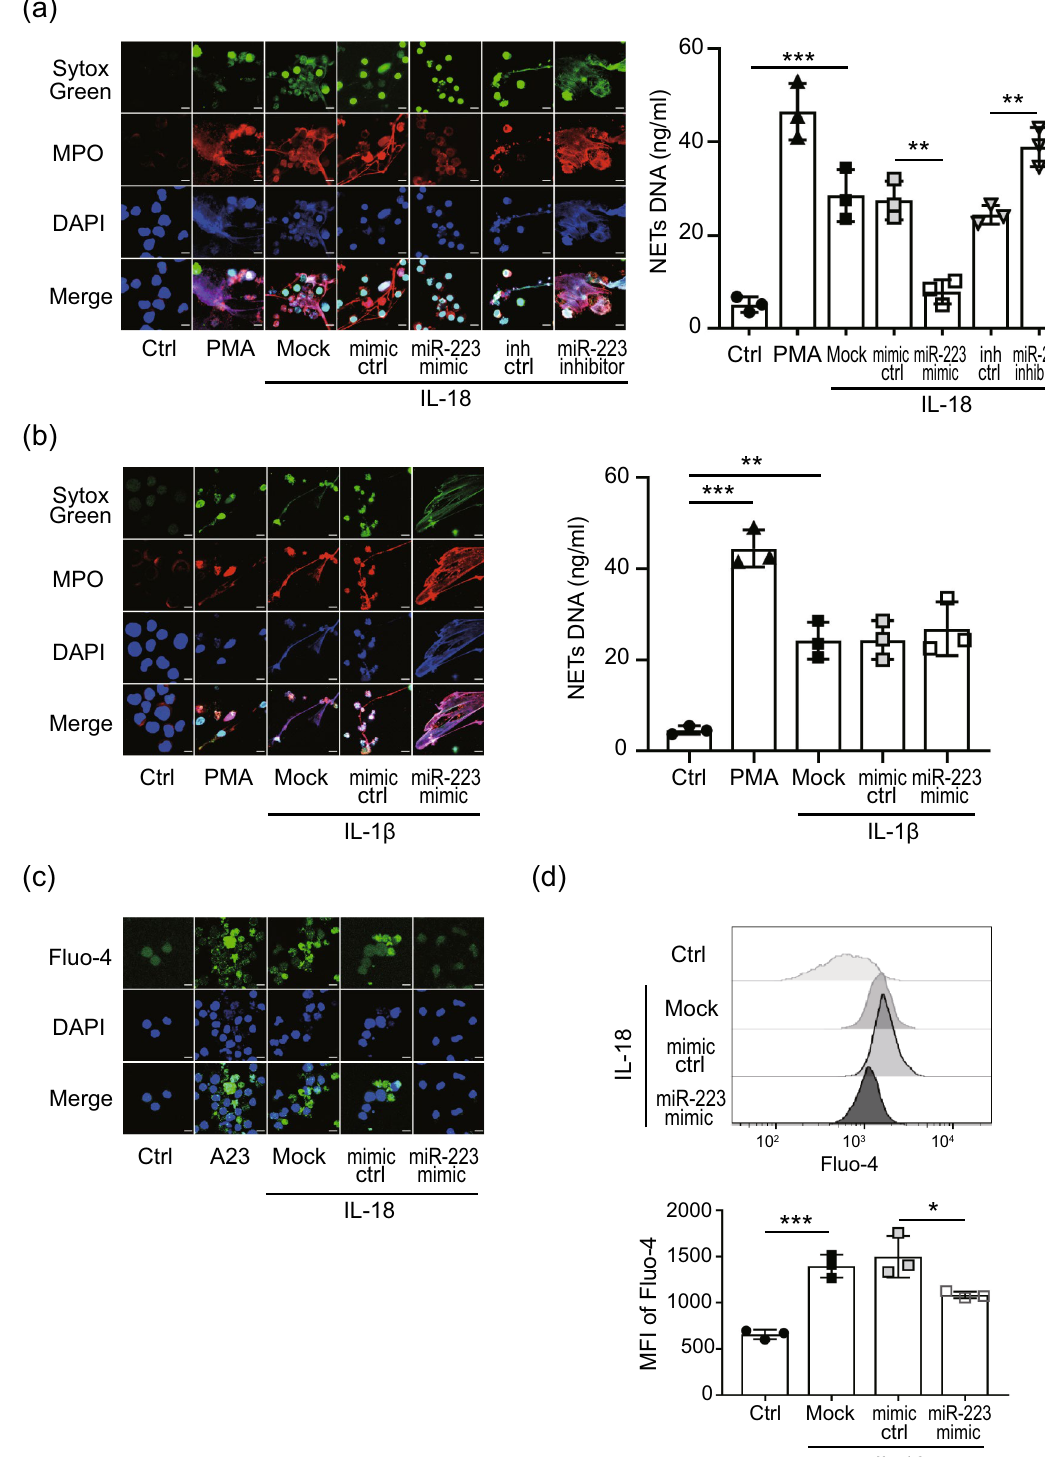
Figure 5. MiR-223 inhibits IL-18-induced NETs by suppressing calcium influx. ( a ) The levels of NETs in miR-223 over-expressing or miR-223 silencing cells after ( a ) IL-18 or (b) IL-1β treatment were detected and quantified. The calcium mobilization in miR-223 over-expressing cells after IL-18 treatment was detected by using Flou-4 staining and quantified with ( c ) confocal microscopy or ( d ) flow cytometry. All experiments were performed in triplicate, and data are presented as the mean ± SD. The scale bar in the IFA image represents 5 μm. ** P < 0.01, *** P <